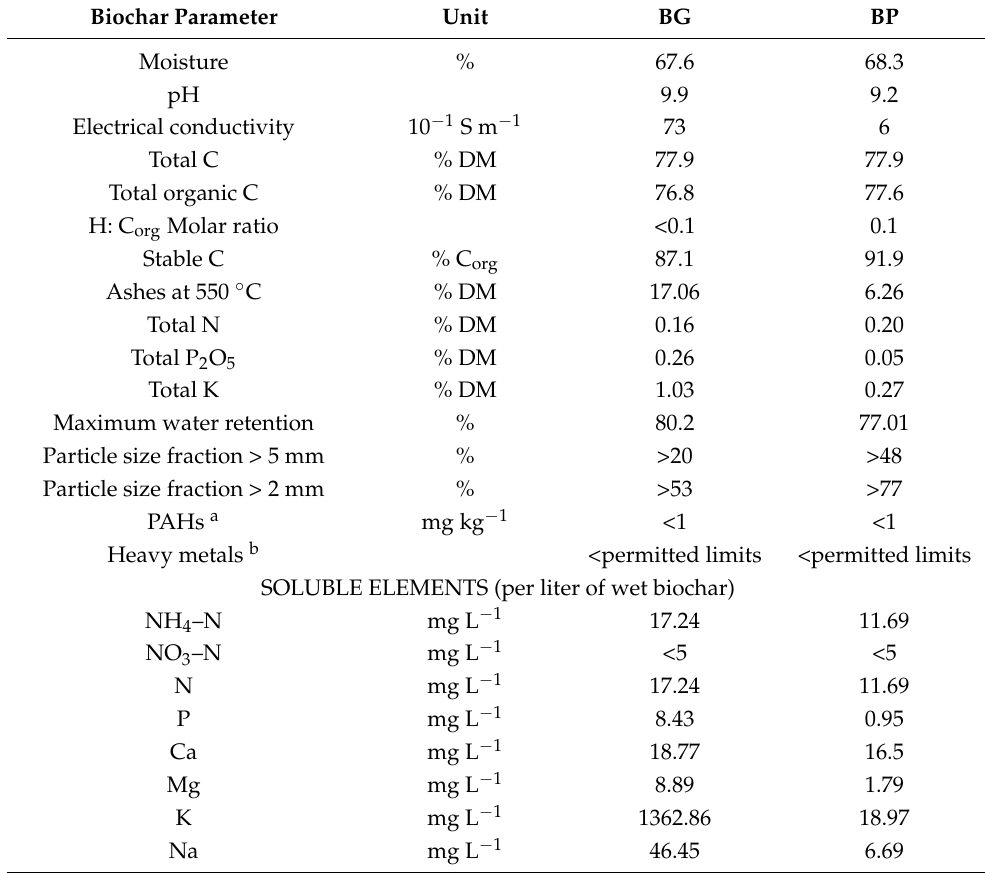
Table 2. Physical and chemical analyses of the two biochar types distributed in